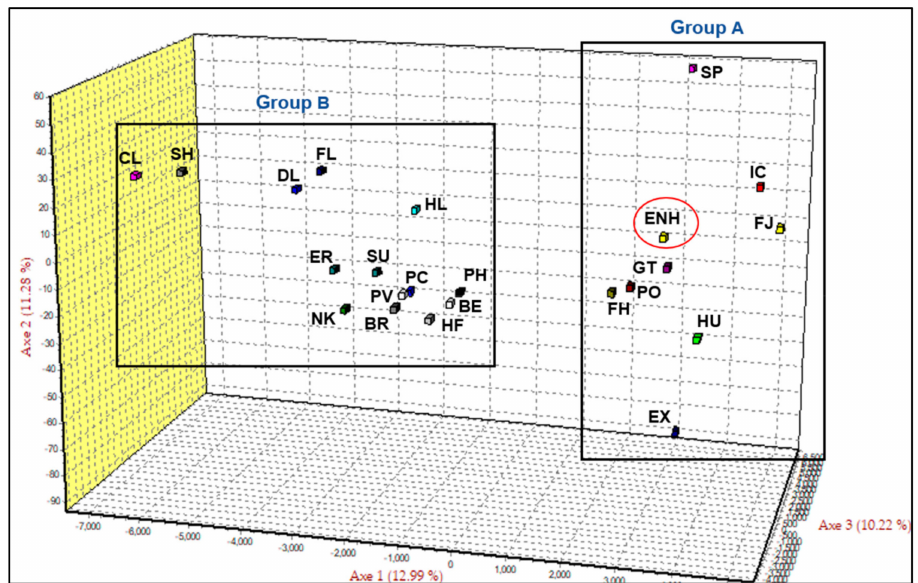
Figure 1. Factorial correspondence analysis (FCA) of Estonian Native Horse (ENH; circled) in comparison with 22 horse breeds. Clydesdale (CL), Shire (SH), Dales Pony (DL), Fell Pony (FL), Highland Pony (HL), Eriskay Pony (ER), Suffolk Punch (SU), Percheron (PC), Noriker (NK), Posavina (PV), Breton (BR), Polish Heavy Horse (PH), Belgian Draught (BE), Haflinger (HF), Hucul (HU), Konik (PO), Finn Horse (FH), Gotland Pony (GT), Icelandic Horse (IC), Norwegian Fjord (FJ), Shetland Pony (SP), Exmoor Pony (EX).